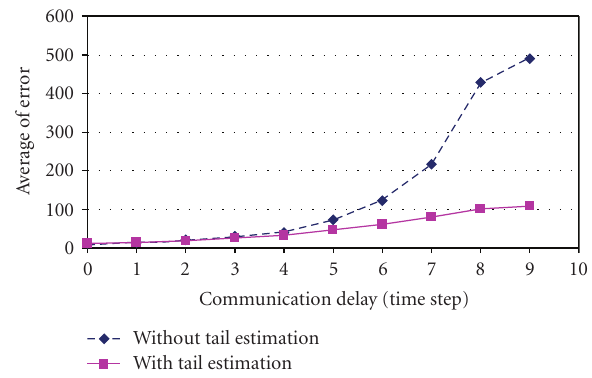
Figure 5: Average of error versus communication delay for a triangle formation of three vehicles.